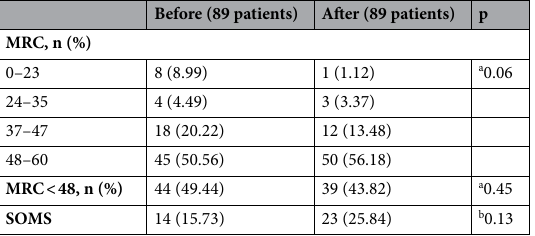
Before (89 patients) After (89 patients)